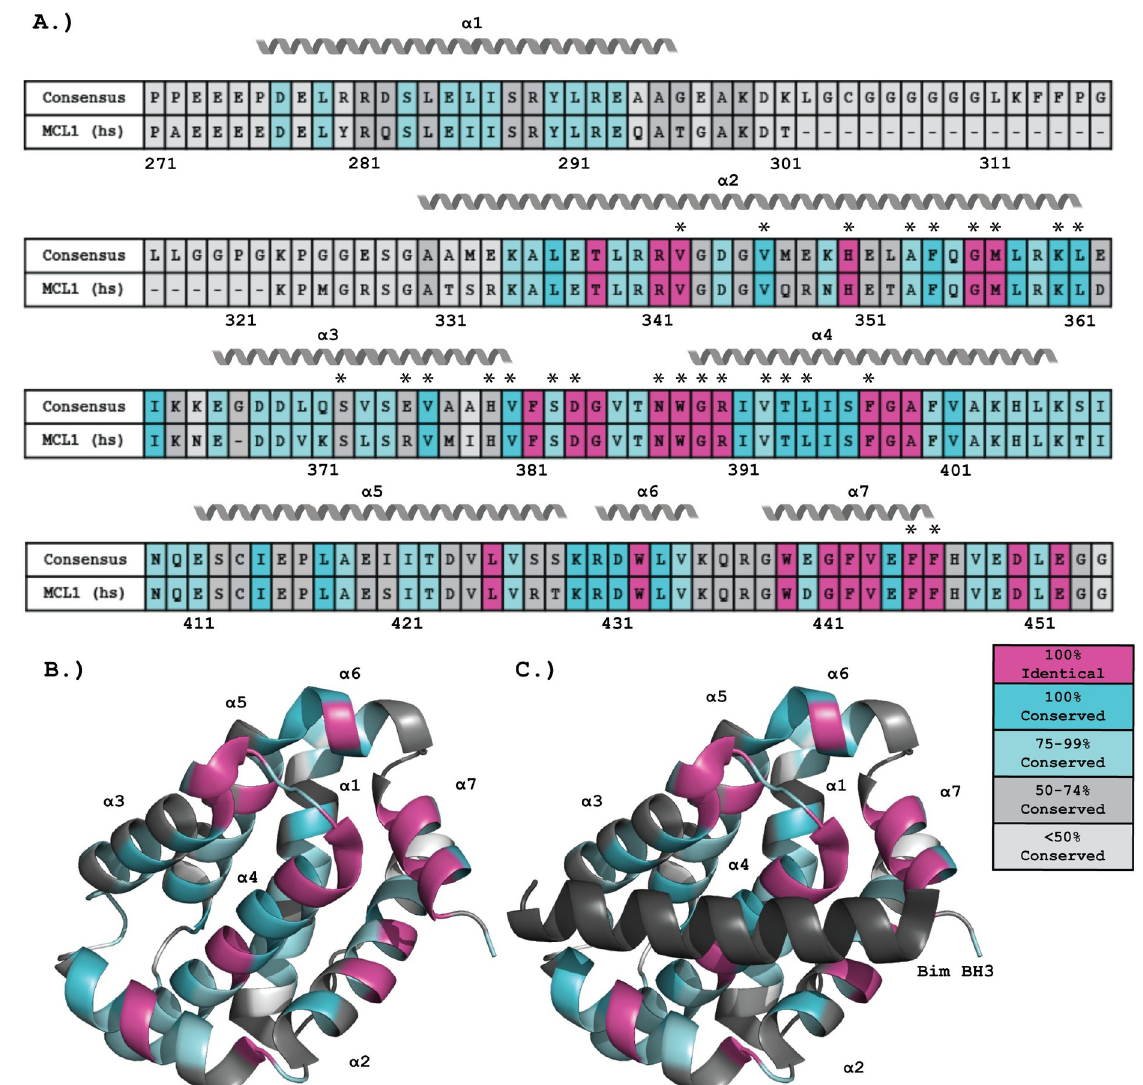
Fig 2. Conservation of the BH3 binding groove of MCL1. Twenty MCL1 sequences from diverse vertebrate organisms were aligned using Clustal Omega [46] to generate a consensus sequence. (A) The consensus sequence of the BH3 binding groove is compared to the corresponding human MCL1 sequence, with residues that are 100% identical in all sequences colored in magenta, identical or homologously conserved in 100% of sequences in dark teal, 75–99% conserved in light teal, 50–74% in dark gray, and less than 50% conserved in light gray. The loop region between residues 302 and 322 is of variable length, and the representative sequence represents its longest variation. The seven alpha helices of MCL1 are indicated above the